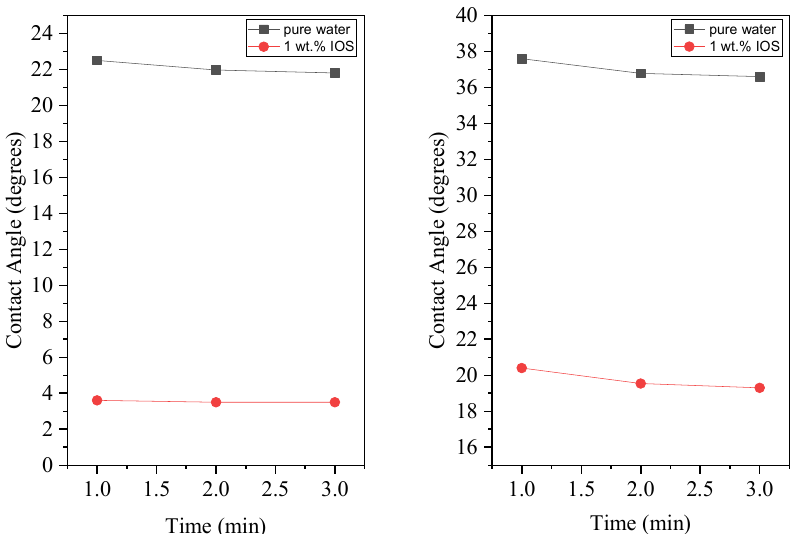
Figure 8. Measured contact angles at ( a ) BG-2 shale surface with pure water and 1 wt.% IOS solution ( b ) KH-2 shale surface with pure water and 1wt.% IOS